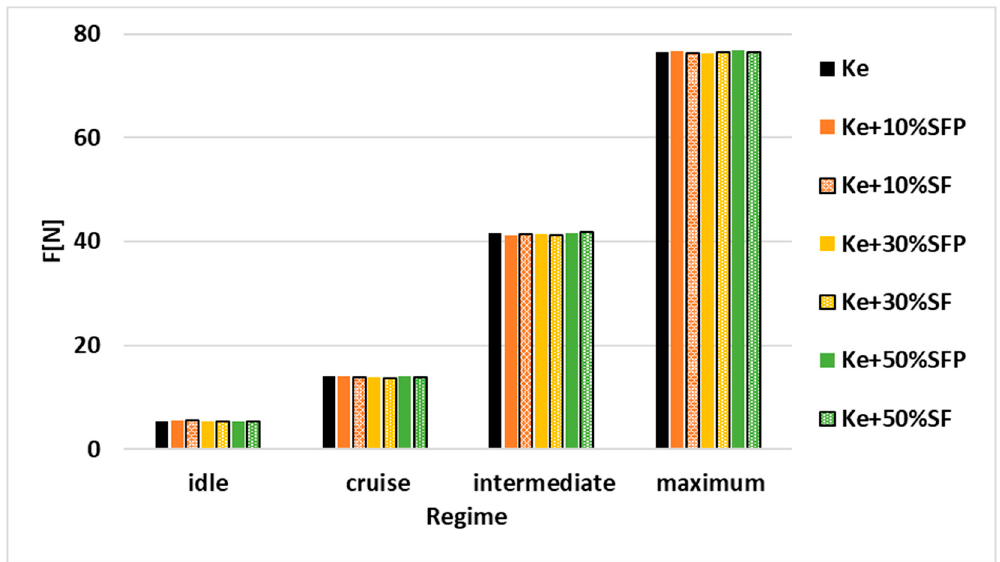
Figure 9. Variation of thrust F[N] depending on the regime and tested blends.